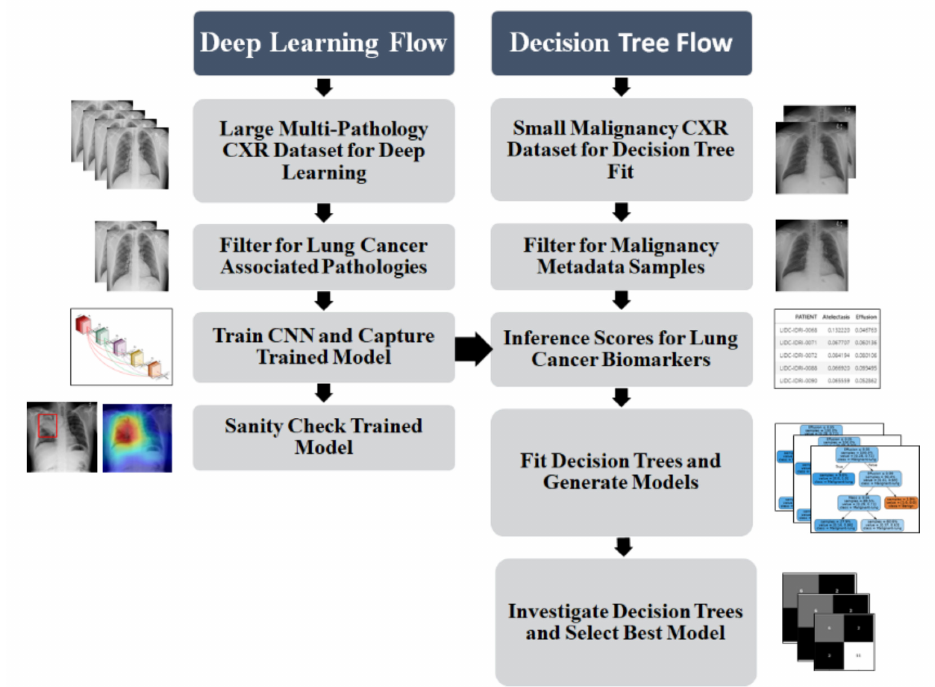
Figure 2. Automated lung cancer malignancy decision tree mining process showing deep learning flow for feature scoring, and decision tree flow for multi-variate model